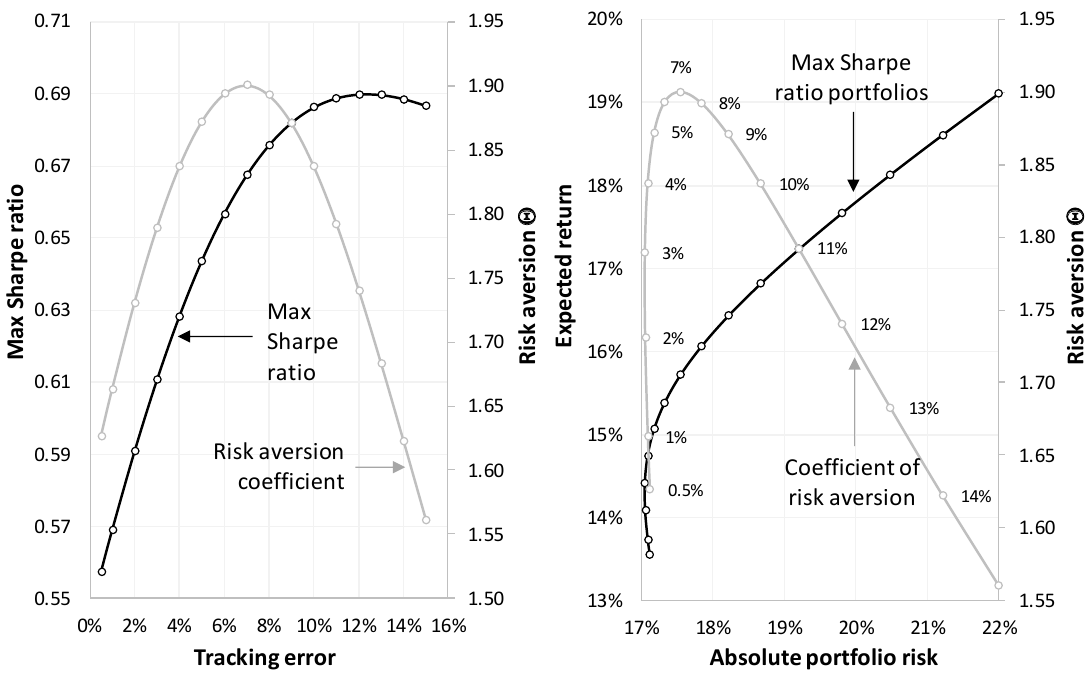
Figure 6. (a) Maximum Sharpe ratio as a function of tracking error and risk-free rate and (b) utility function (risk aversion) as a function of tracking error and portfolio